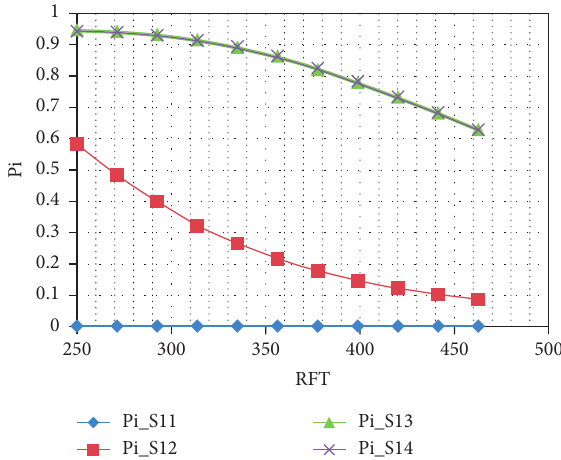
Figure 14: P I versus RFT for 4 scenarios, showing increasing contribution values of